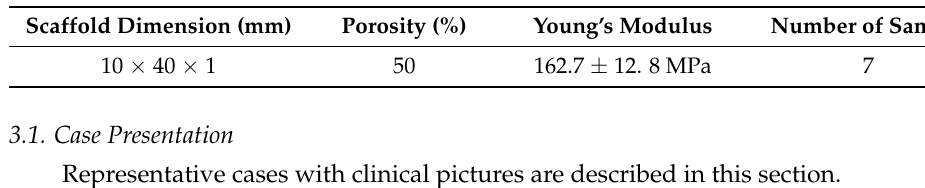
Table 4. Experimental result of mechanical property test.